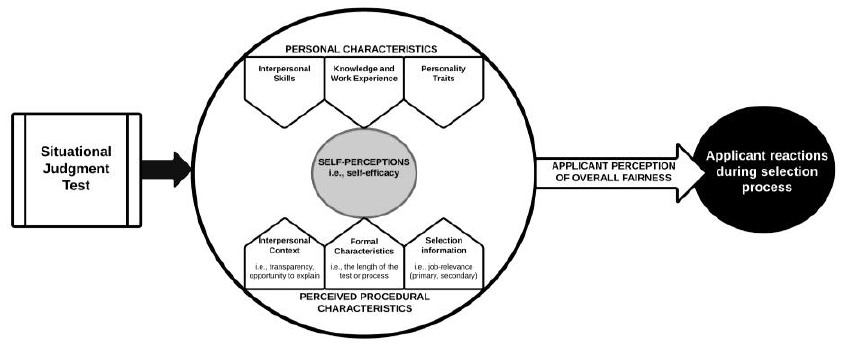
Figure 1. An integrated model in which situational judgment tests influence applicants’ personal characteristics and perceived procedural characteristics. Note. The model was influenced by previous work by Gilliland (1993), Hausknecht et al. (2004), and Patterson et al.